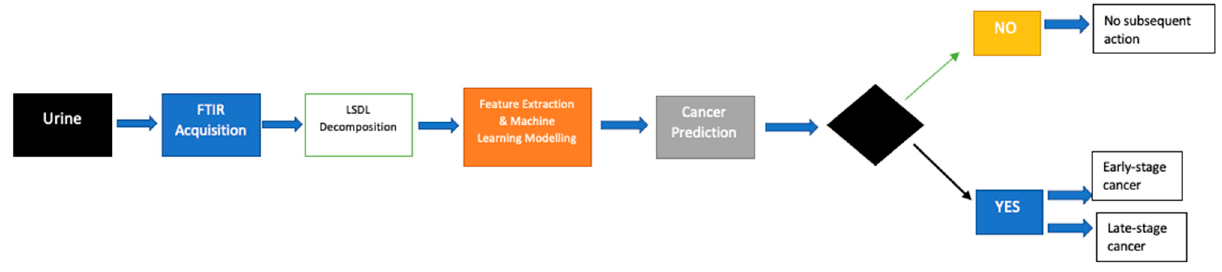
Figure 3. Flow diagram showing the operational flow of the proposed modeling approach.